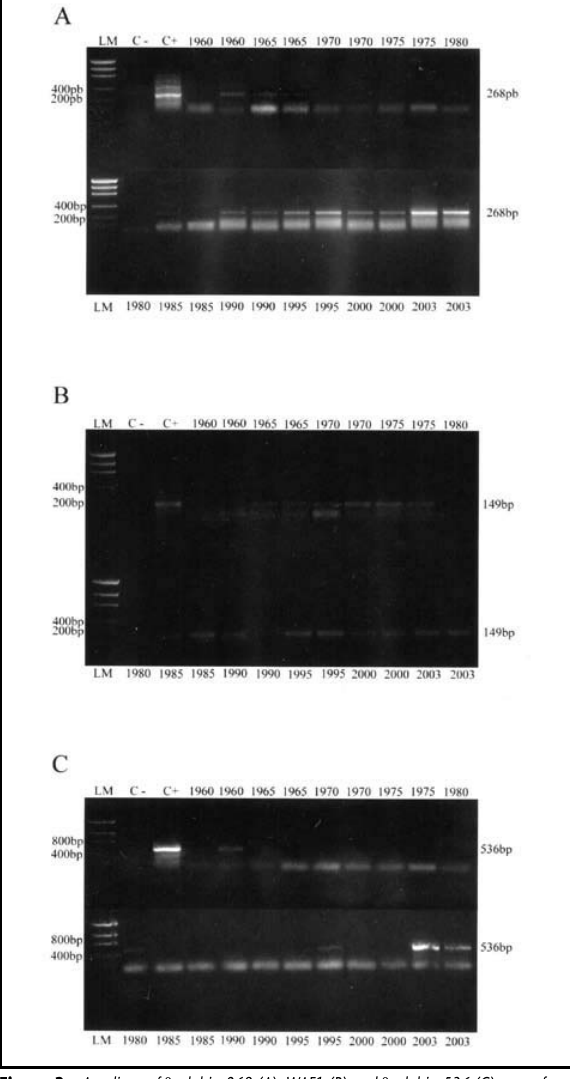
Figure 3 – Amplicon of (cid:69) -globin-268 (A), WAF1 (B) and (cid:69) -globin-536 (C) genes from genomic DNA obtained from different storage time archival tissue (PCR technique; original magnification) LM: low mass; C-: negative control; C+: positive